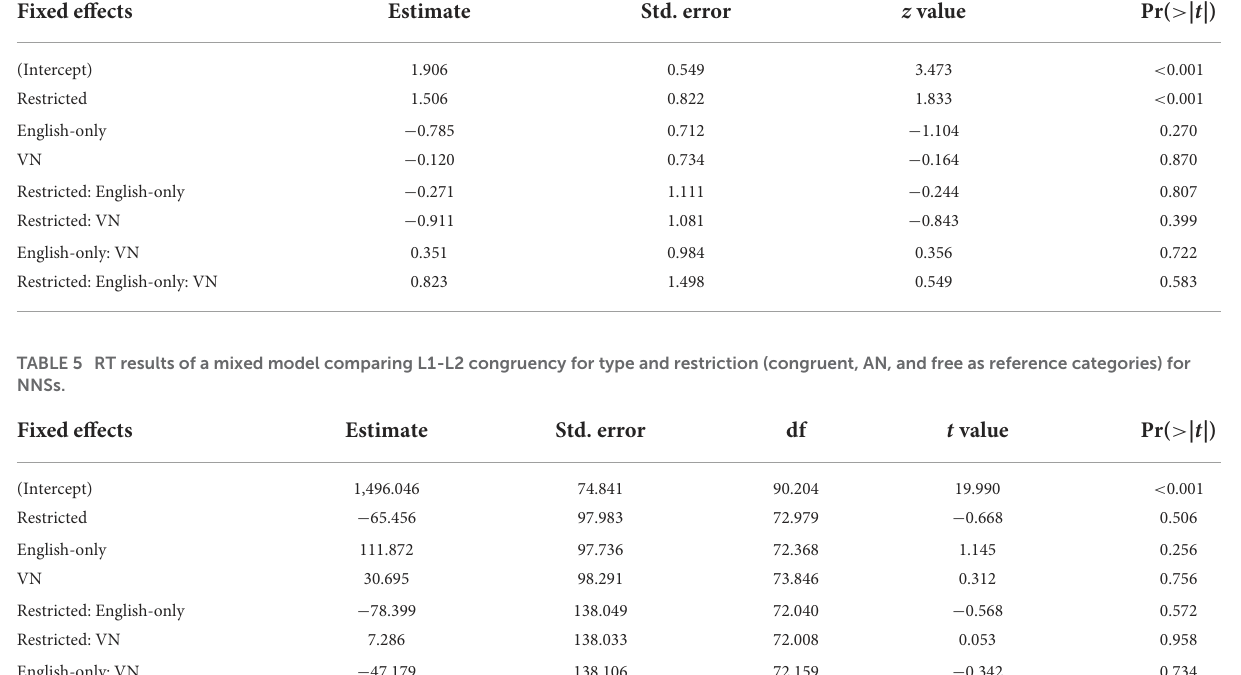
TABLE 4 ACC results of a mixed model comparing L1-L2 congruency for type and restriction (congruent, AN, and free as reference categories) for NSs. Fixed effects